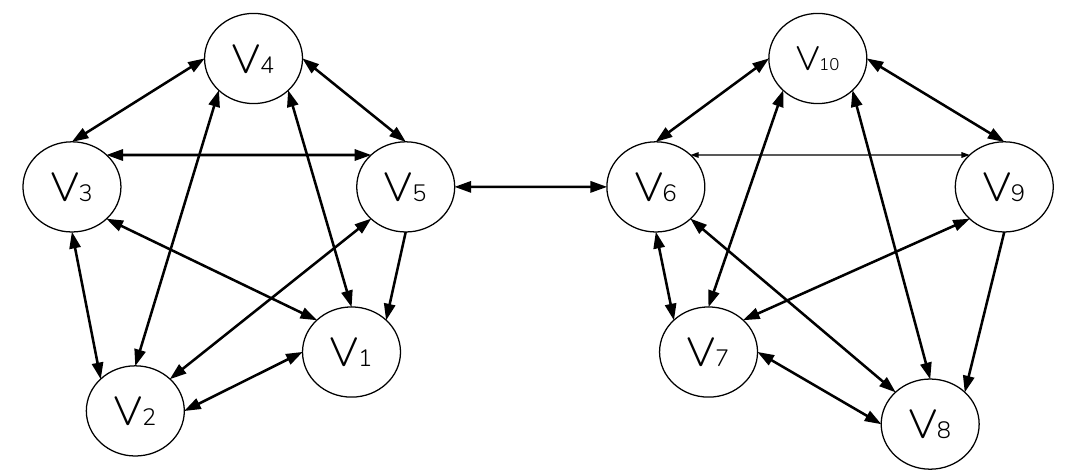
Figure 2. Two quorum slices, intersecting at nodes { v 5 , v 6 } .